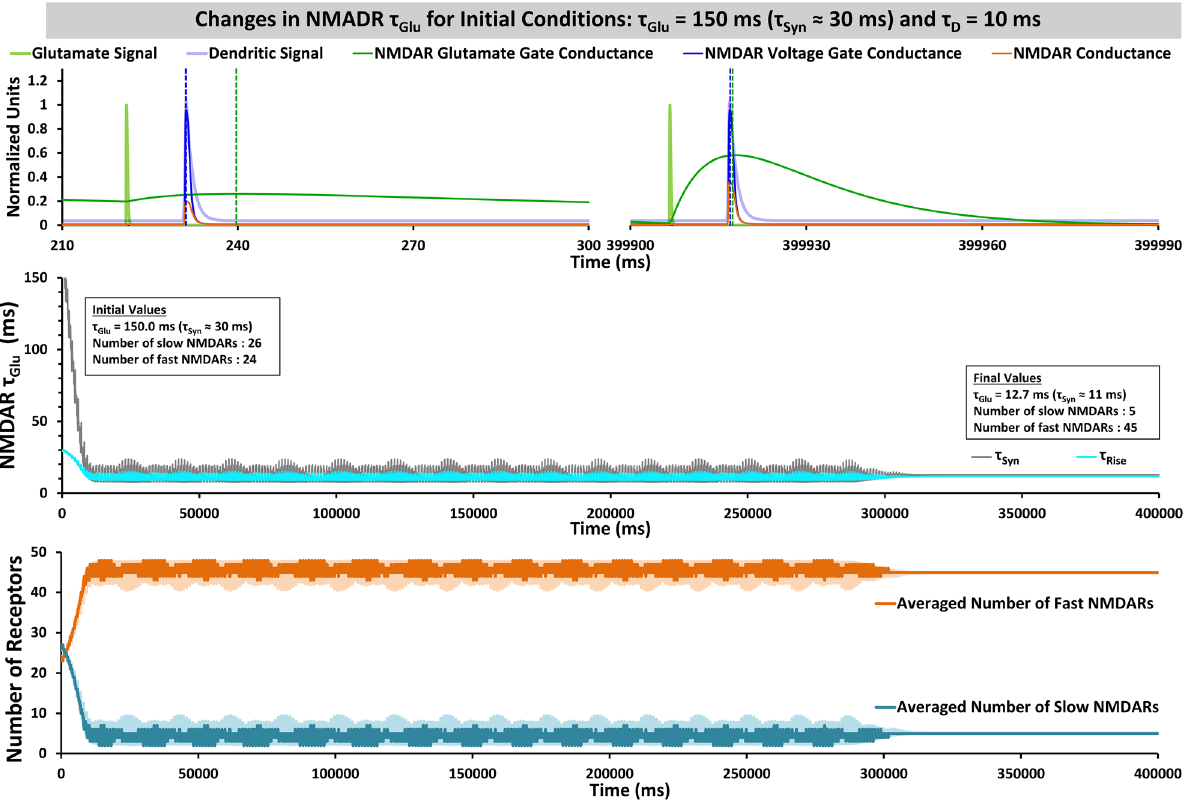
Figure 4. Simulation of the SITDL synapse model, showing changes in τ Glu , and corresponding changes in numbers of slow and fast NMDARs. This simulation was run with plasticity and stabilization mechanisms for τ Glu , with initial conditions τ Glu = 150 ms and τ D = 10 ms, and with constants for calculating the numbers of slow and fast NMDARs n Total = 50, τ Fast = 7 ms, and τ Slow = 50 ms. ( A) Segments of 90 ms close to the start and end of the simulation are shown at the left and right, respectively, with g Glu and g V peaks (green and blue dashed lines) noticeably becoming more coincident. ( B) shows the time course of τ Glu , with an initial value of 150 ms (τ Syn ≈ 30 ms), which corresponds to the synapse having 26 slow NMDARs and 24 fast NMDARs. τ Glu decreases overall, with some oscillation, until it stabilizes at 12.7 ms (τ Syn ≈ 11 ms), which corresponds to 5 slow NMDARs and 45 fast NMDARs in the synapse, indicating a replacement of slow NMDARs with fast NMDARs. ( C) shows the corresponding numbers of slow and fast NDMARs over time, each averaged over a 800 ms time window (darker